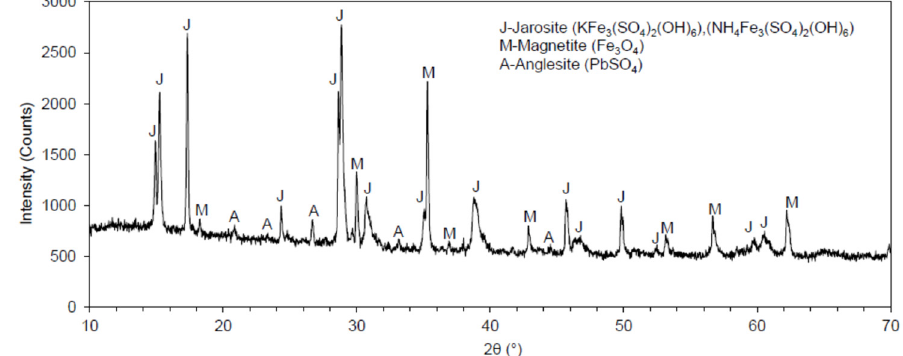
Figure 3. Di ff ractogram of the jarosite tailings waste sample. Figure 3. Diffractogram of the jarosite tailings waste sample.